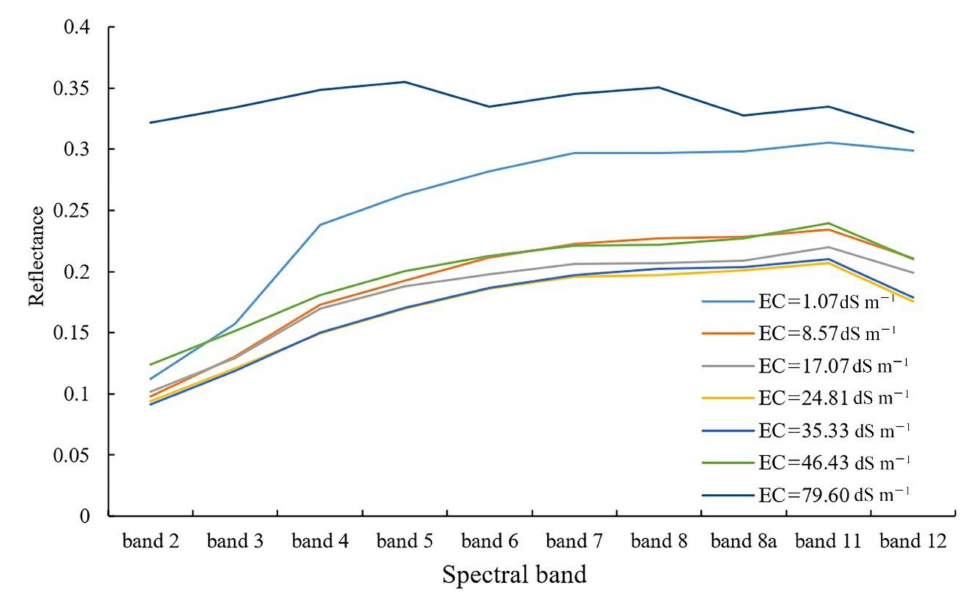
Figure 3. Reflectance of the soil samples with different salinity levels in the Sentinel-2 spectral bands. To examine the sensitivity of the Sentinel-2B MSI-derived covariates (spectral bands, PC image, vegetation index, TCW, DEM, and satellite salinity indices) to the soil EC,